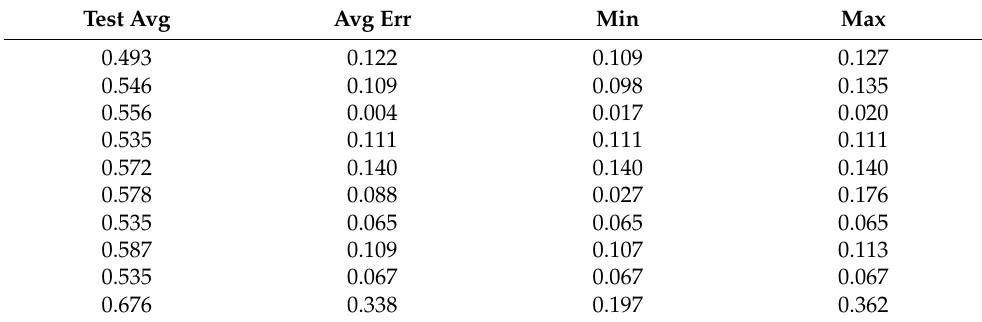
Table A208. Set 3, trials 31–40 data (average actual PR values).